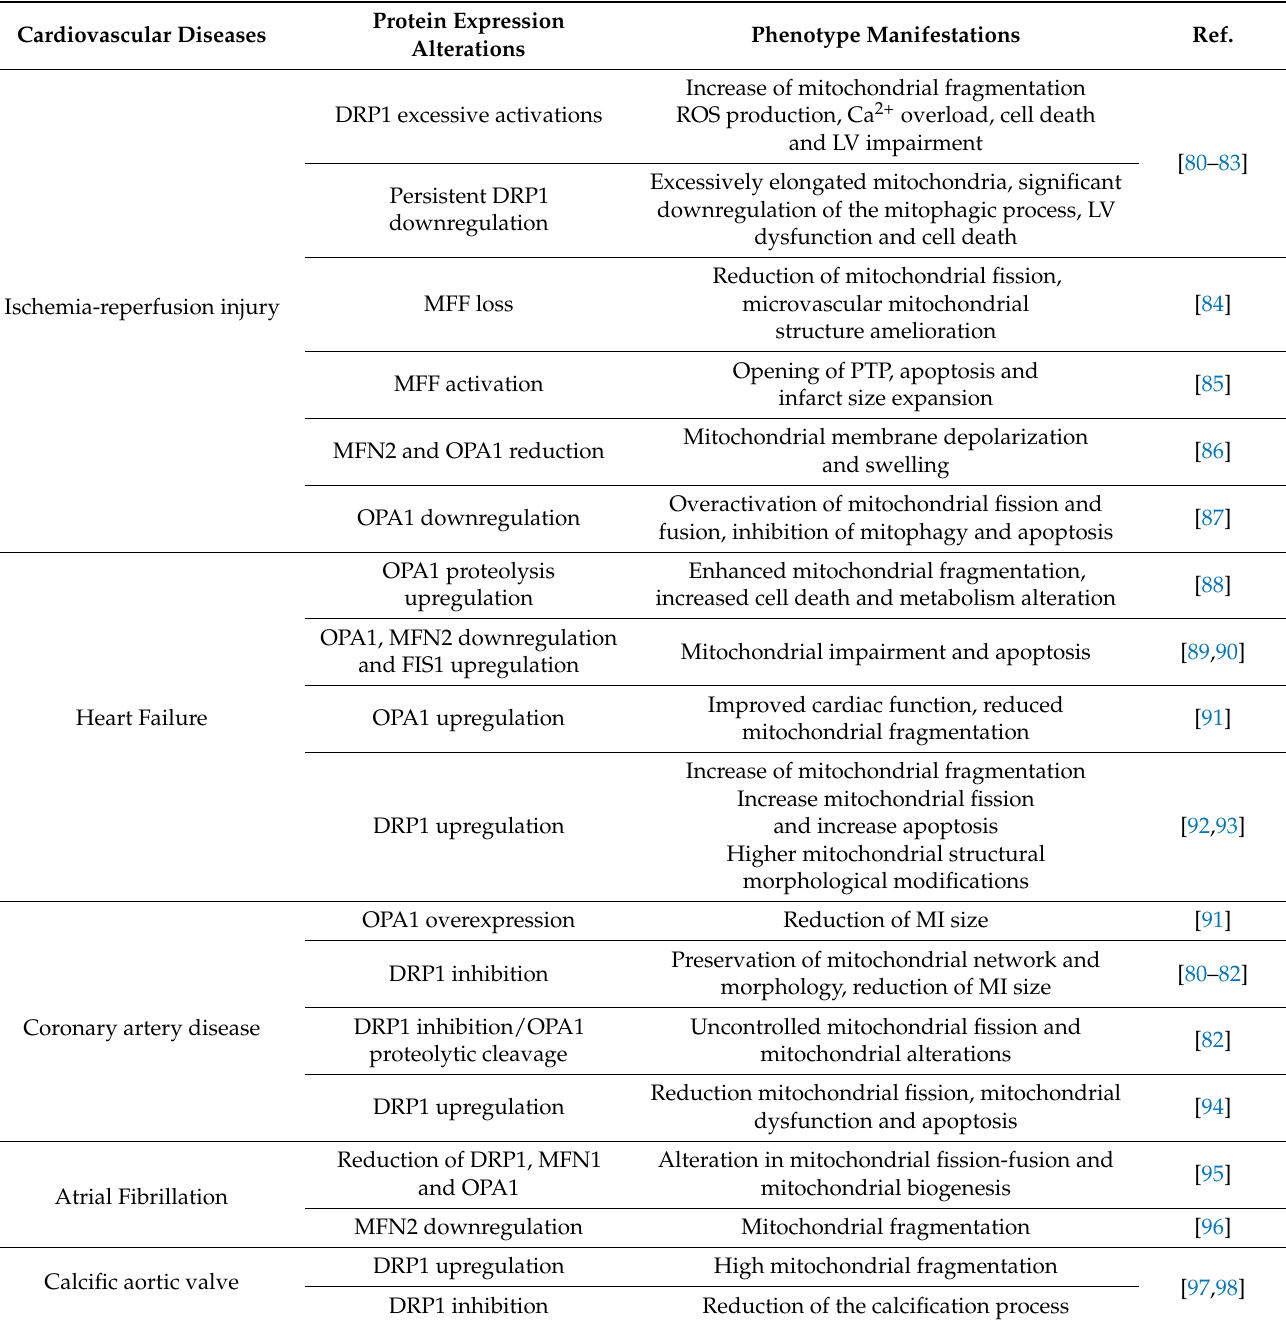
Table 1. Representative list summarizing alterations in mitochondrial dynamics in different cardio- vascular